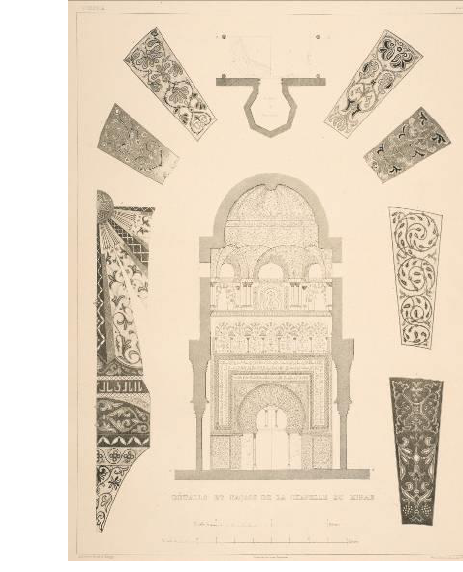
Figure 7. Girault de Prangey: ( a ) Front view from the forest of columns and mihrab (Villemin, lit.); ( b ) Mihrab side view (Wyld, lit.). Source: Monuments arabes et moresques de Cordoue, 1839.